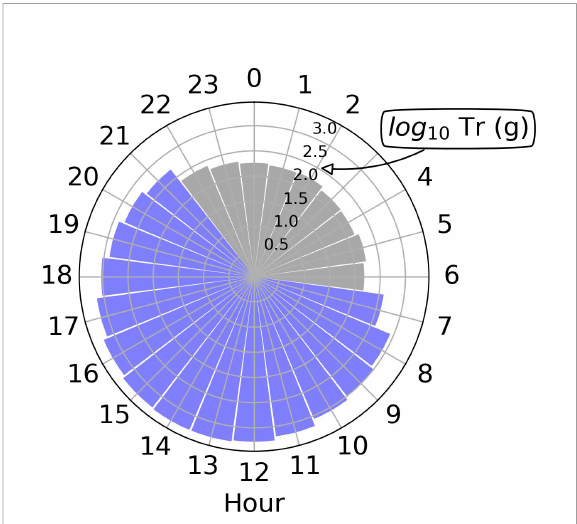
FIGURE 5 Total daytime and nighttime transpiration per hour of the day for the well-watered